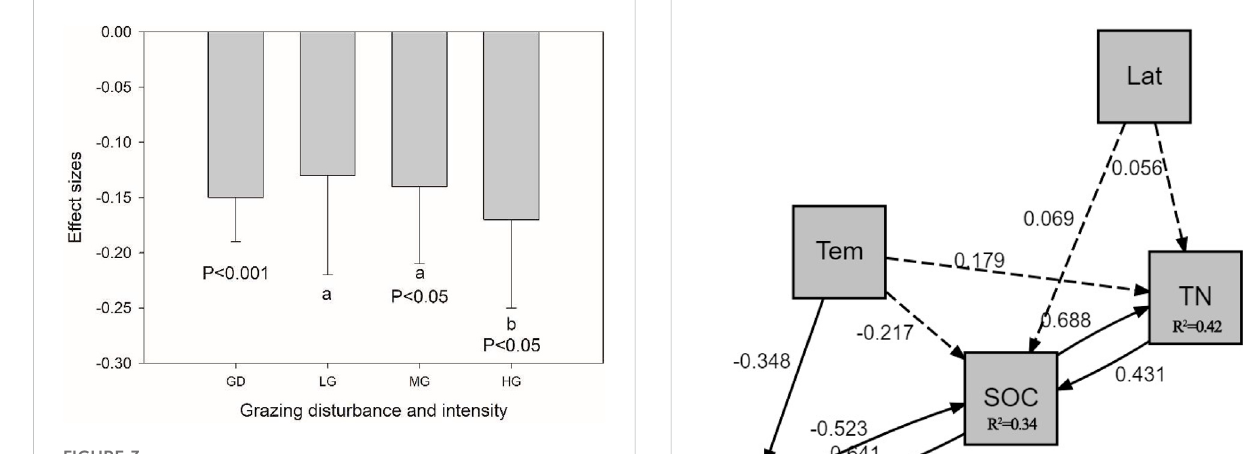
FIGURE 3 EffectsizeofgrazingdisturbanceonalpinemeadowsSOConthe TibetanPlateau.Note:GD,LG,MGandHGmeantgrazingdisturbance, light grazing, moderate and heavy grazing. Different letters meant there was signi fi cant difference among three grazing intensities. Values of P indicated that there was signi fi cant difference on effect sizes of grazed grassland SOC contents. FIGURE 4